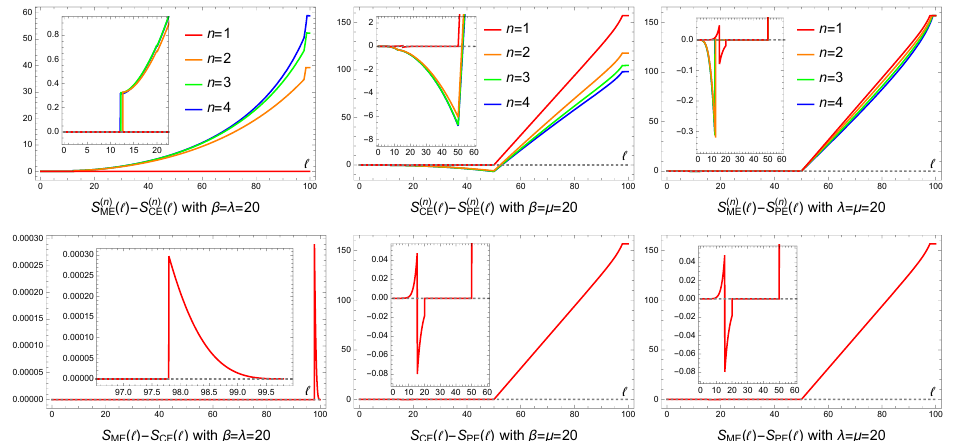
Figure 4 . The di(cid:11)erences of R(cid:19)enyi entropies (in upper row) and entanglement entropies (in lower row) in the canonical ensemble, microcanonical ensemble, and primary excited states from (2.10), (3.8), and (4.3). As we cannot calculate the precise various critical lengthes, i.e. ‘ CE , ‘ ME , ‘ PE , the (cid:12)gures around these critical lengthes are just suggestive. We also remind the 1 ; 2 1 ; 2 reader that the medium interval R(cid:19)enyi entropy in the primary excited state (4.2) is a conjecture, and so the corresponding R(cid:19)enyi entropy and entanglement entropy di(cid:11)erences are also conjectures and thus suggestive. Especially, the medium interval regime of entanglement entropy di(cid:11)erence S CE ( ‘ ) (cid:0) S PE ( ‘ ) (middle of the 2nd row) should be nonvanishing. To draw the (cid:12)gures we have set c = 30, L =